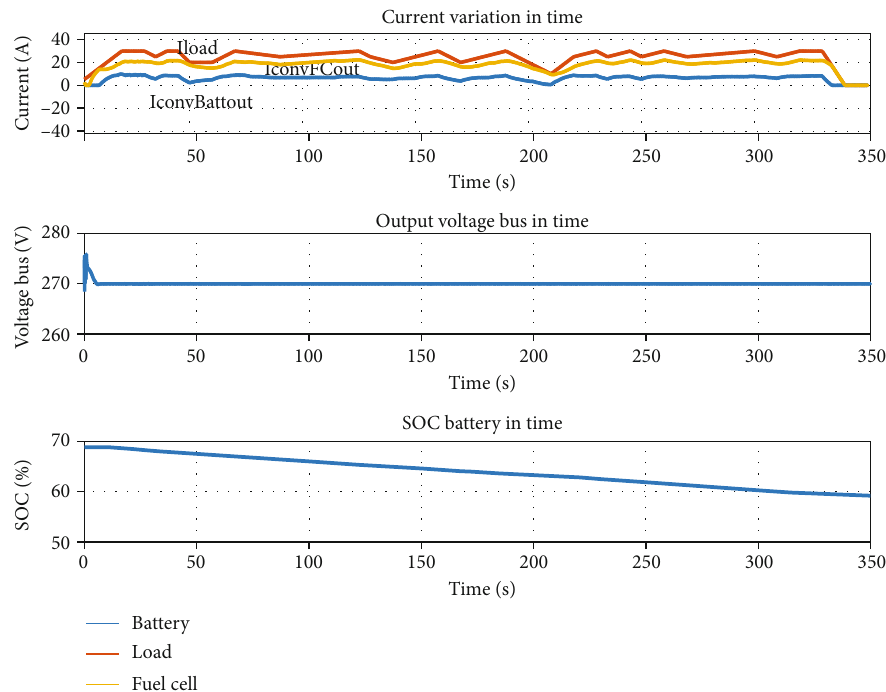
Figure 13: Simulation results for load pro fi le used in case